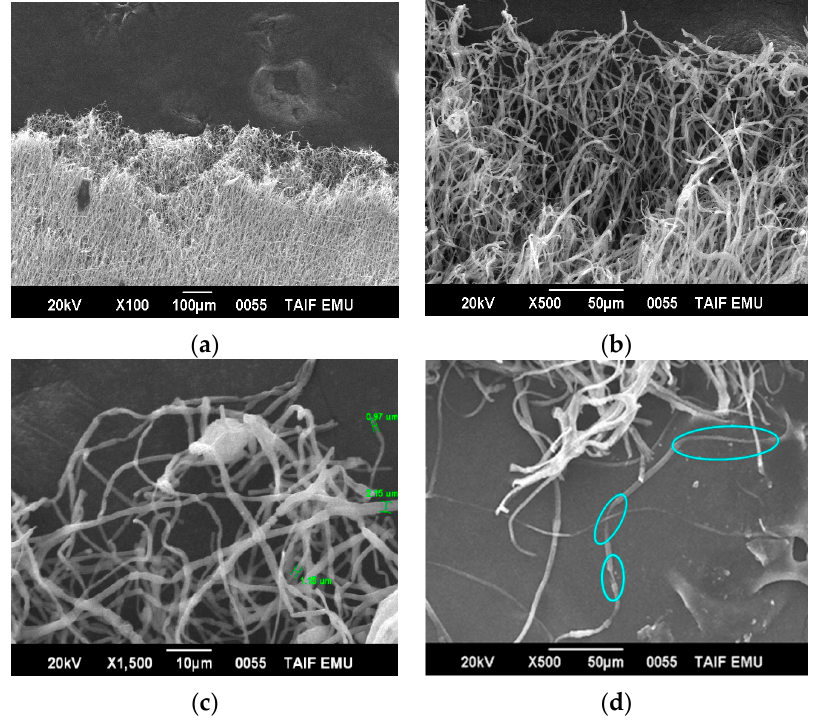
Figure 6. SEM micrographs of fractured surfaces of multiple neck formations in electrospun fibers of blend 2 ( a , b , and c ) and blend 1 ( d ) after cold drawing, at different magnifications.